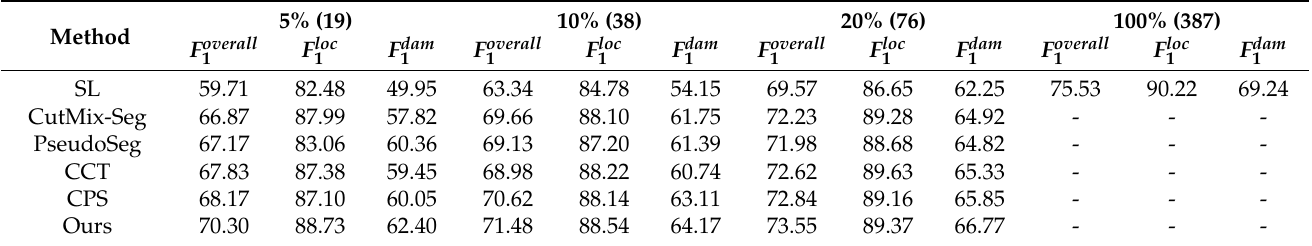
Table 3. Quantitative comparison of different SSL methods on the Joplin dataset (%).